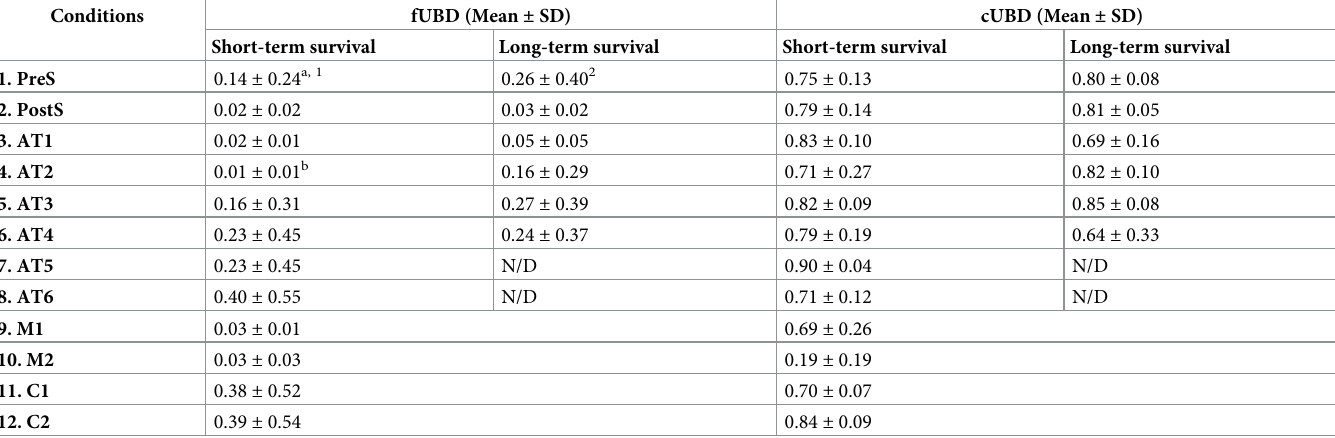
Table 4. Free ubiquitin D (fUBD) and conjugated ubiquitin D (cUBD) in patients with short-term survival ( < 12 m after surgery) and long-term survival ( > 12 m after surgery) at different time